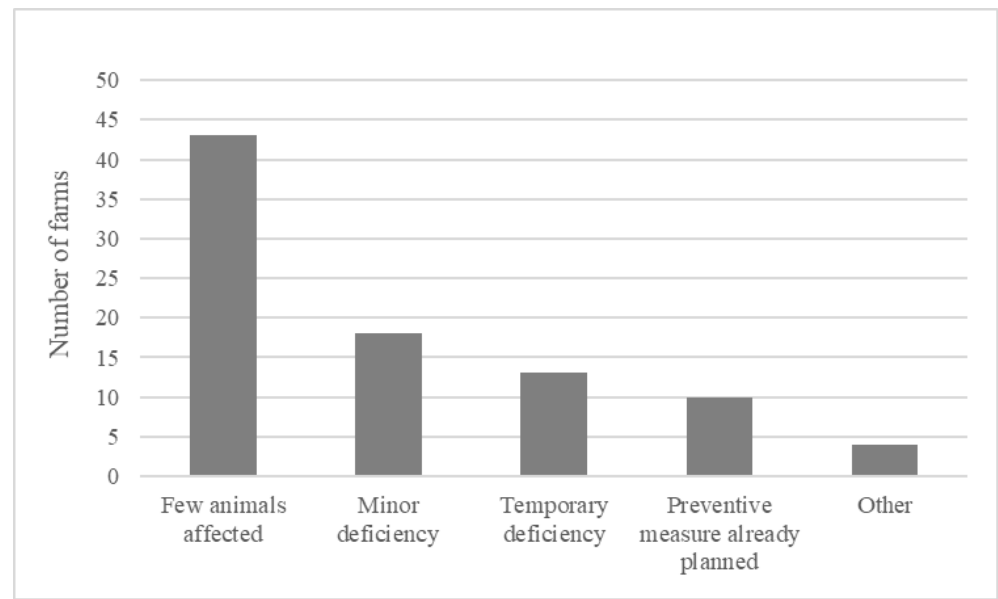
Figure 1. Reasons stated by animal welfare inspectors for categorizing 56 farms as compliant with Swedish animal welfare legislation on animal cleanliness, despite dirty animals being observed during inspections. One or several reasons could be given.